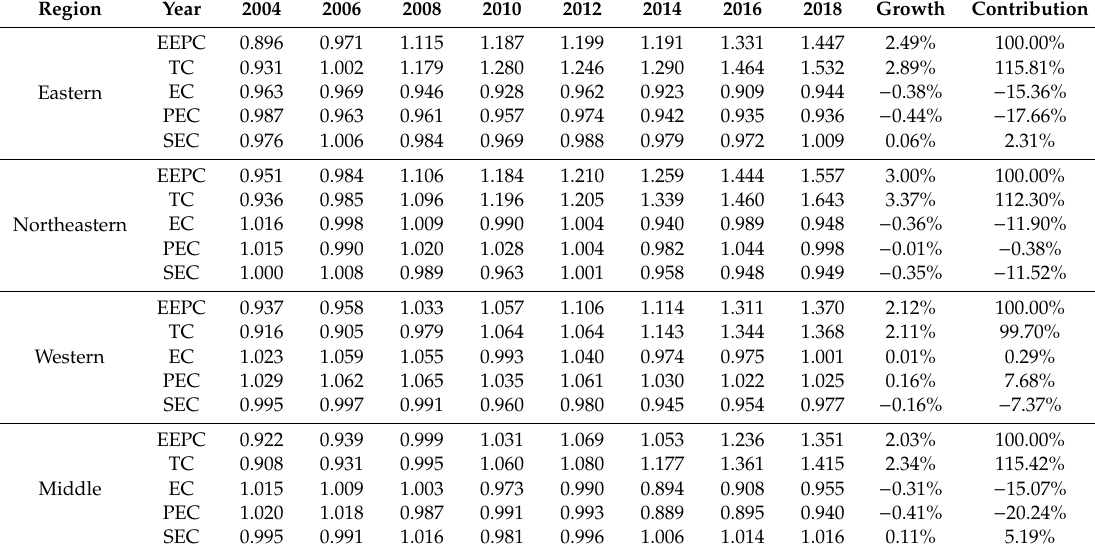
Table 5. Cumulative value of EEPC and its decomposition for classification by